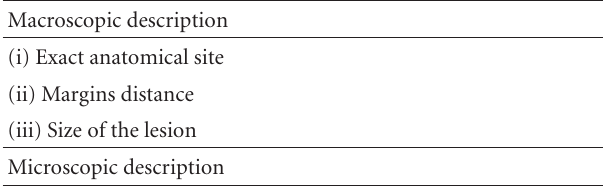
Table 1: Tumor-node-metastasis definitions in the European Neu- roendocrine Tumor Society (ENETS) for staging for pancreatic neuroendocrine tumors [14, 15].